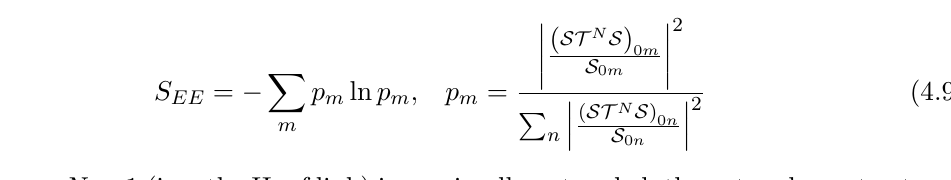
as a function of k . The blue line is an interpolating 1